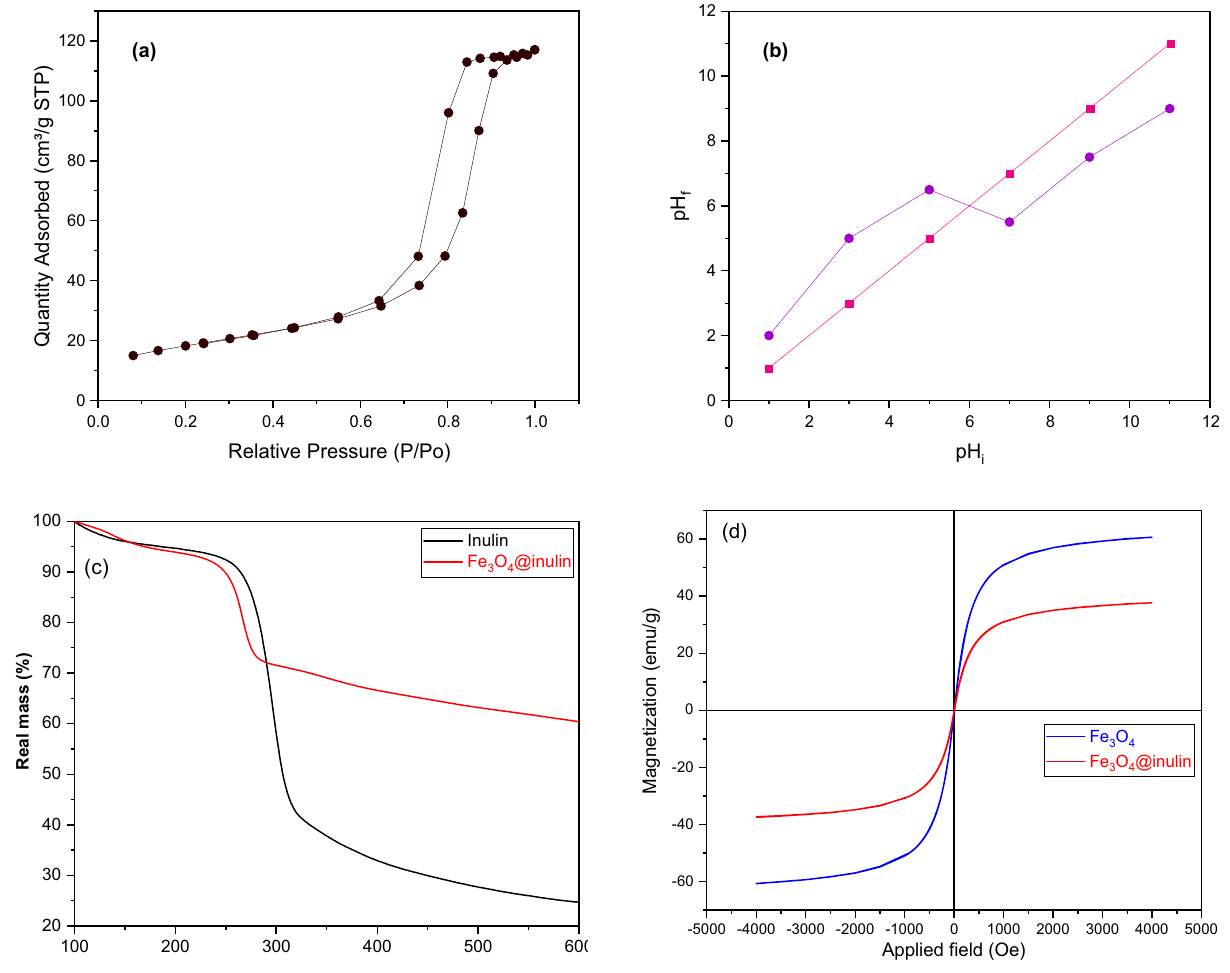
Figure 3. ( a ) N 2 adsorption/desorption curve of the Fe 3 O 4 @inulin adsorbent; ( b ) pH f versus pH i for determining pH ZPC of the Fe 3 O 4 @inulin nanocomposite; ( c ) TGA curves of inulin and Fe 3 O 4 @inulin; ( d ) magnetic hysteresis curves of Fe 3 O 4 and Fe 3 O 4